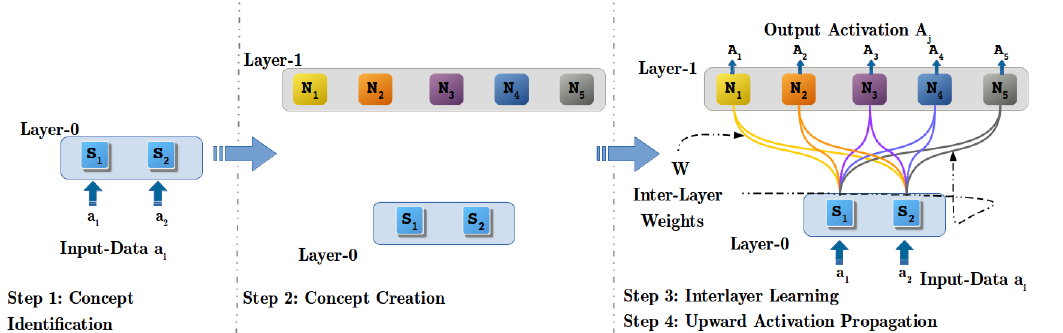
Figure 4. Steps in model generation with Regulated Activation